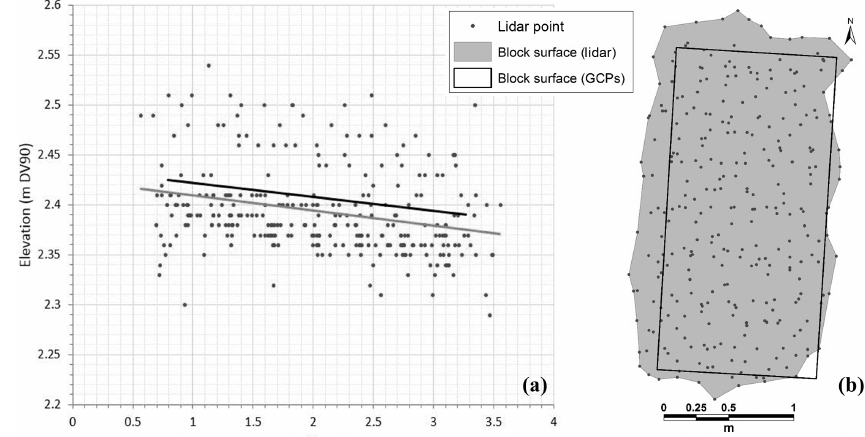
Figure 8. Vertical and horizontal distribution of the lidar points describing the block surface and the actual block surface derived from GCPs. (a) lidar points (grey dots) compared to the GCP block surface (black line) for determining the vertical accuracy. The grey line shows the lidar block surface as a best linear fit through the points. (b) Block surface derived from the four GCP corner points and the block surface derived by the perimeter of the lidar